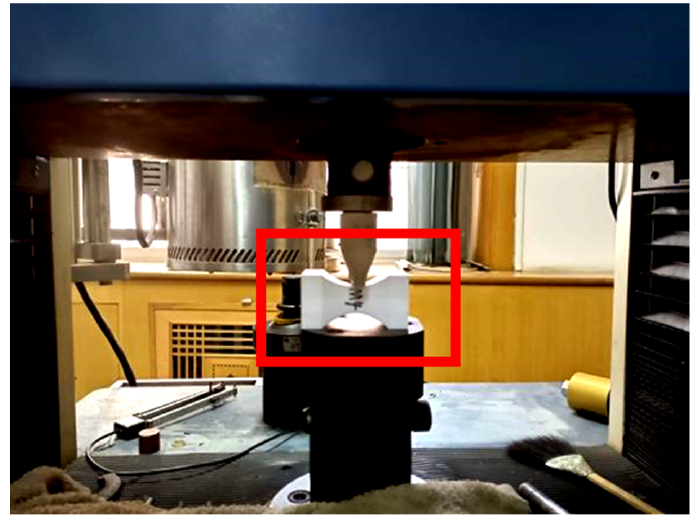
Figure 6. The photograph of the three-point bending test.